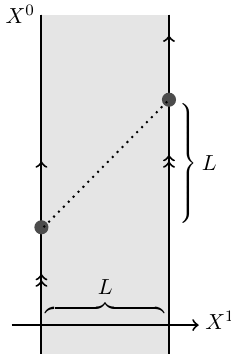
Figure 2 . The geometry of the longitudinal spacetime as a cylinder with a shift on one end. The two end points of the dashed line are